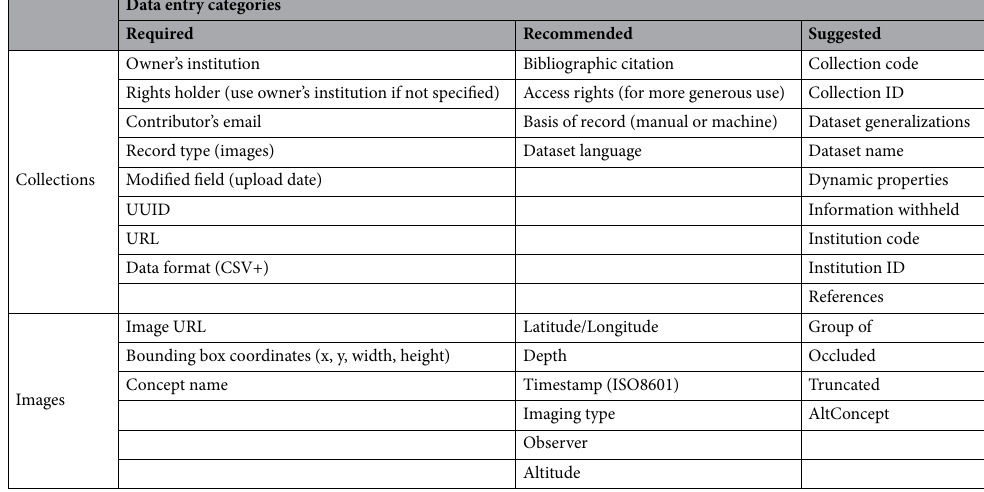
Table 1. Data entry categories for Collections (corresponding to a single upload) and Images that make up the collections, divided into required, recommended, and suggested fields. The data entry categories for Collections are from the Darwin CORE Archive data